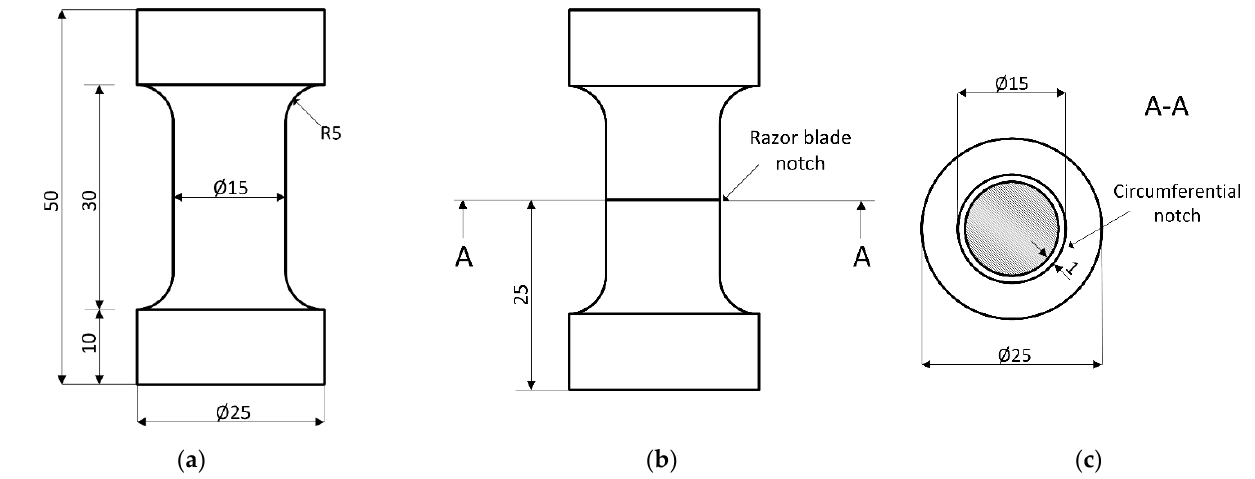
Figure 1. ( a ) Geometry and dimensions of the axisymmetric dumbbell specimens used in the fatigue experiments; ( b ) geometry of the Cracked Round Bar (CRB) specimen; ( c ) Section A-A of the CRB specimen with the circumferential notch.